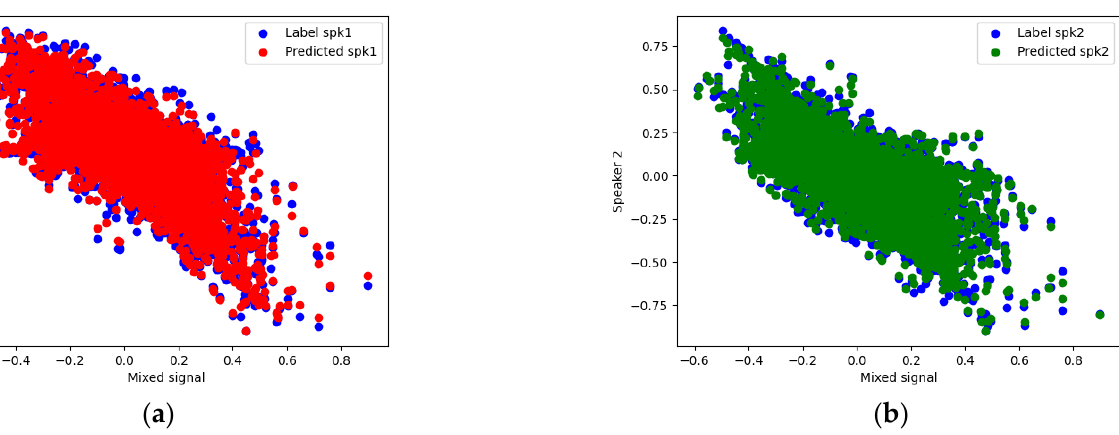
Figure 7. Comparison diagram of the predicted speaker speech and real speaker tag. ( a ) Comparison of speaker 1 ’ s separation results and labels; ( b ) Comparison of speaker 2 ’ s separation results and labels. The coincidence degree between two-speaker speech separated by the model and the original speech data tag is ideal, which verifies the generalization effect of the model.